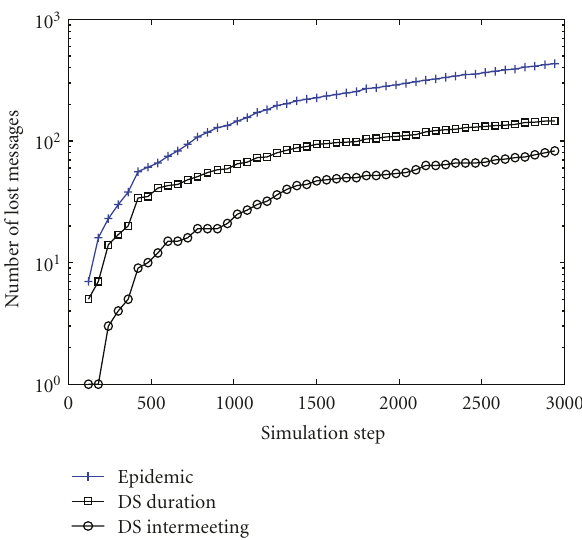
Figure 5: Number of lost messages under di ff erent routing schemes.